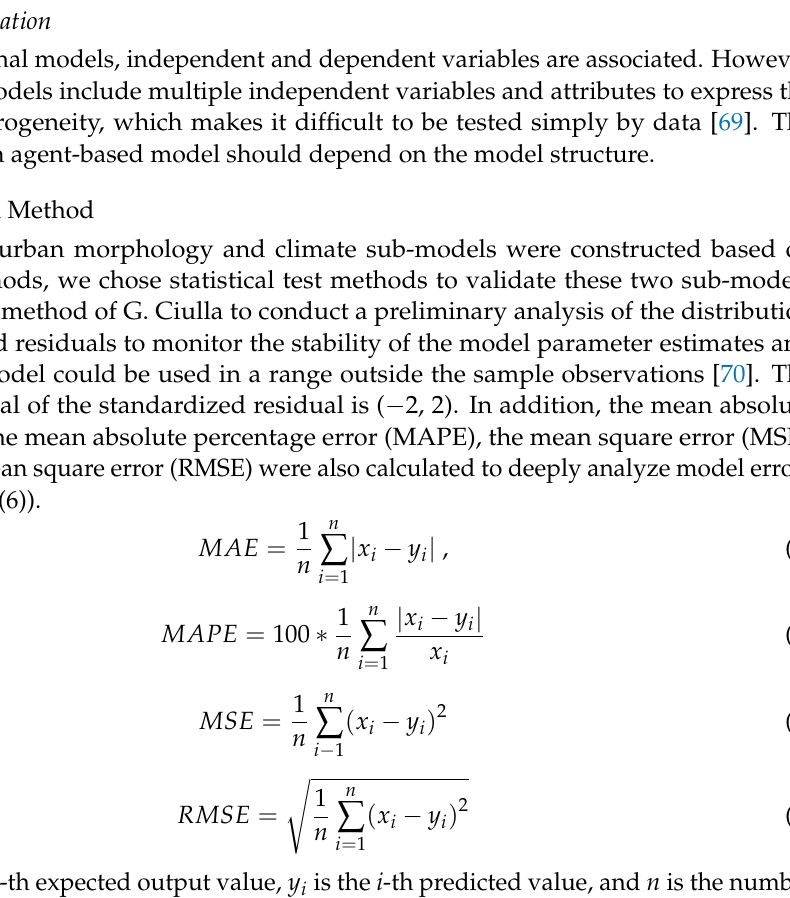
Figure 10. Update settings of climate sub-model data.